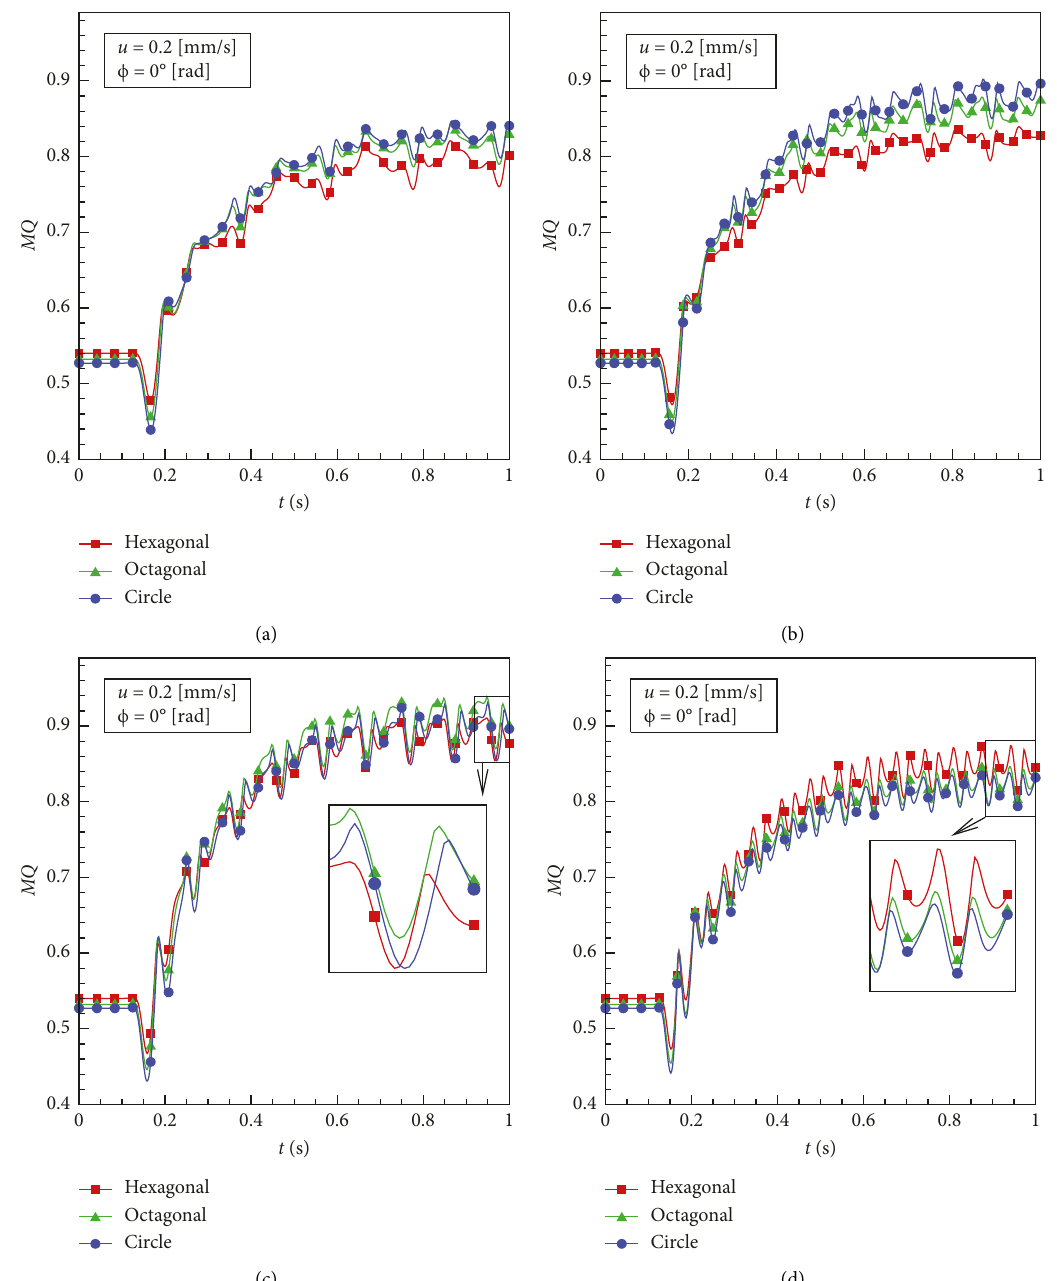
Figure 9: Mixing efficiency in three mixing chambers at u � 0.2 mm · s − 1 and φ � 0 for different frequencies: (a) 5Hz; (b) 7 Hz; (c) 10Hz; and (d) 15Hz.